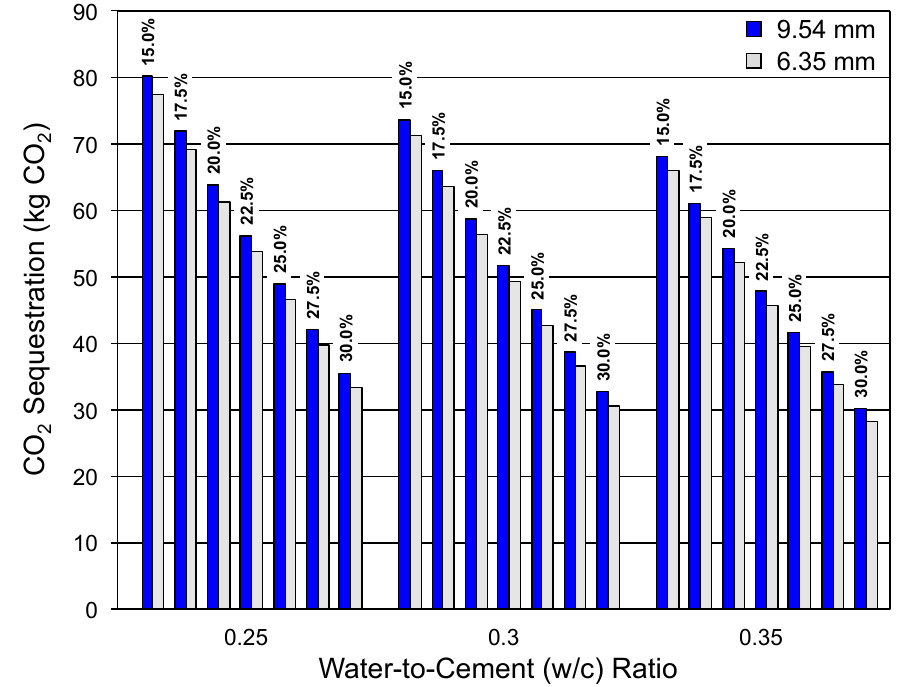
Figure 3. CO 2 sequestration potential for 1 m 3 of pervious concrete. Design porosity of each mixture is indicated above its respective column. Aggregate size is differentiated by color.